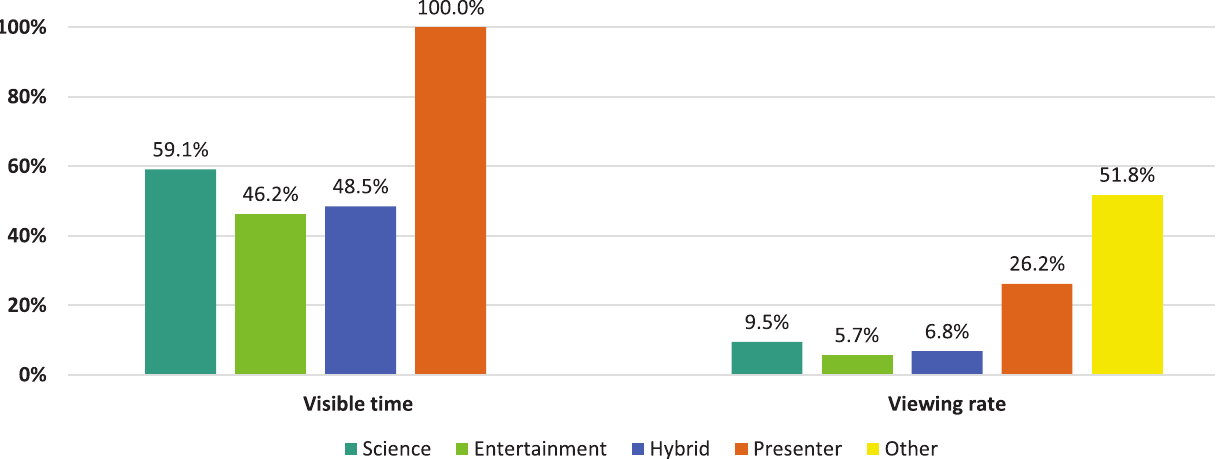
Figure 5. Cumulative visible time (as percentage of total reception time) and viewing rate (gaze time on visible elements as percentage of total reception time) for the three categories and the presenter in the presentation by Reinhard Remfort. Note: The category “other” in the section viewing rate includes gazes on all other, unclassified elements in the scenery.